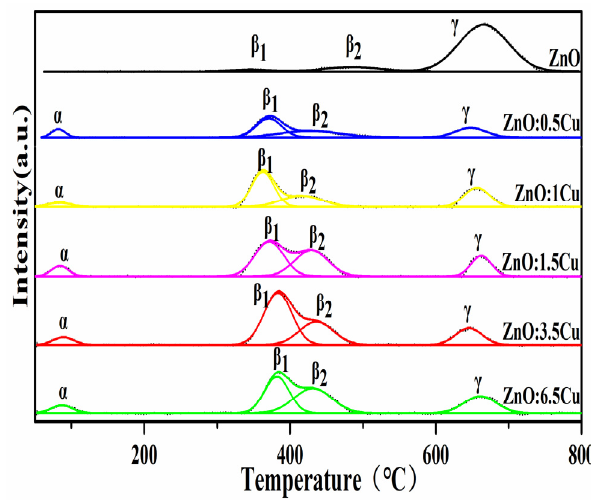
Figure 6. CO 2 temperature-programmed desorption (CO 2 -TPD) profiles of the reduced pure ZnO and ZnO:XCu model catalysts, X = 0.5, 1.0, 1.5, 3.5, 6.5. Table 2. CO 2 desorption capabilities of the reduced pure ZnO and ZnO:XCu model catalysts. Samples